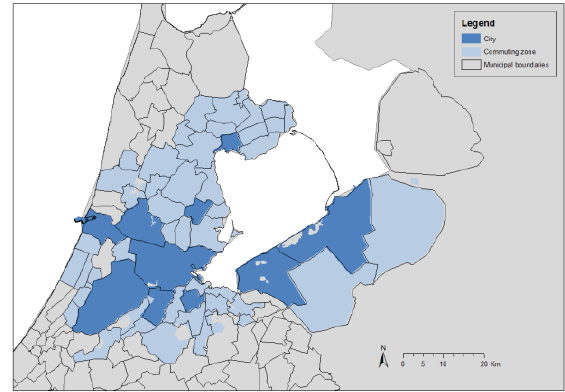
Figure 10. Amsterdam Functional Urban